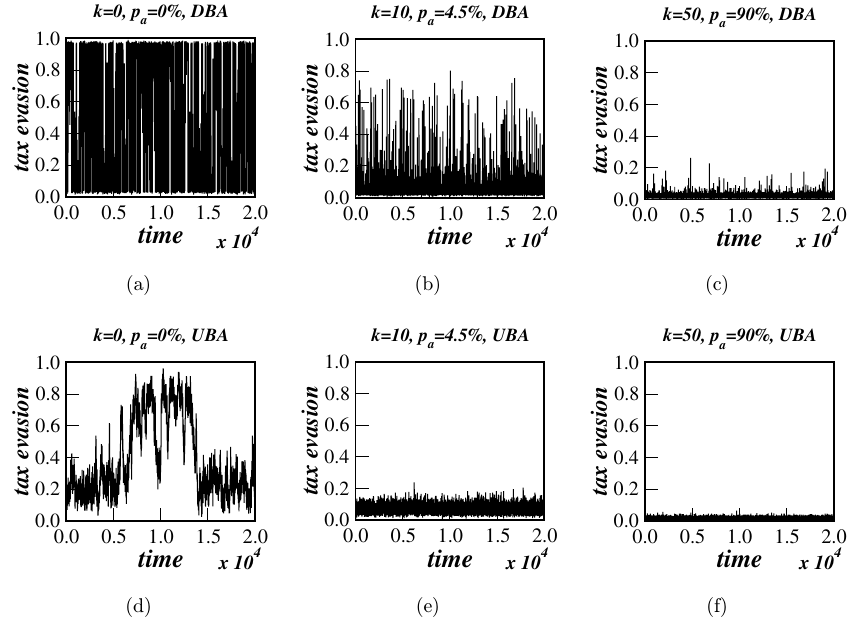
Fig. 2. Baseline case: p a ¼ 0 % and k ¼ 0 in (a) and (d). In (b) and (e) we have the realistic case with punishment k ¼ 10 and audit probability p a ¼ 4 : 5 % , 36,7 and for (c) and (f) we have an extreme case of punishment k ¼ 50 and audit probability p a ¼ 90 % . 7 We perform all simulations over 20 ; 000 time steps, also in the later